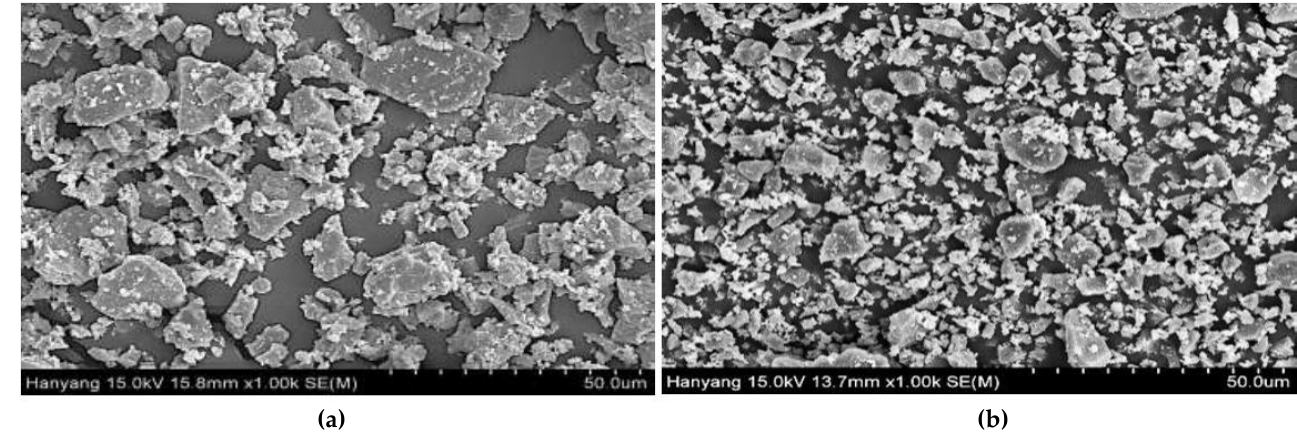
Figure 1. SEM of ( a ) OPC and ( b ) WCP.